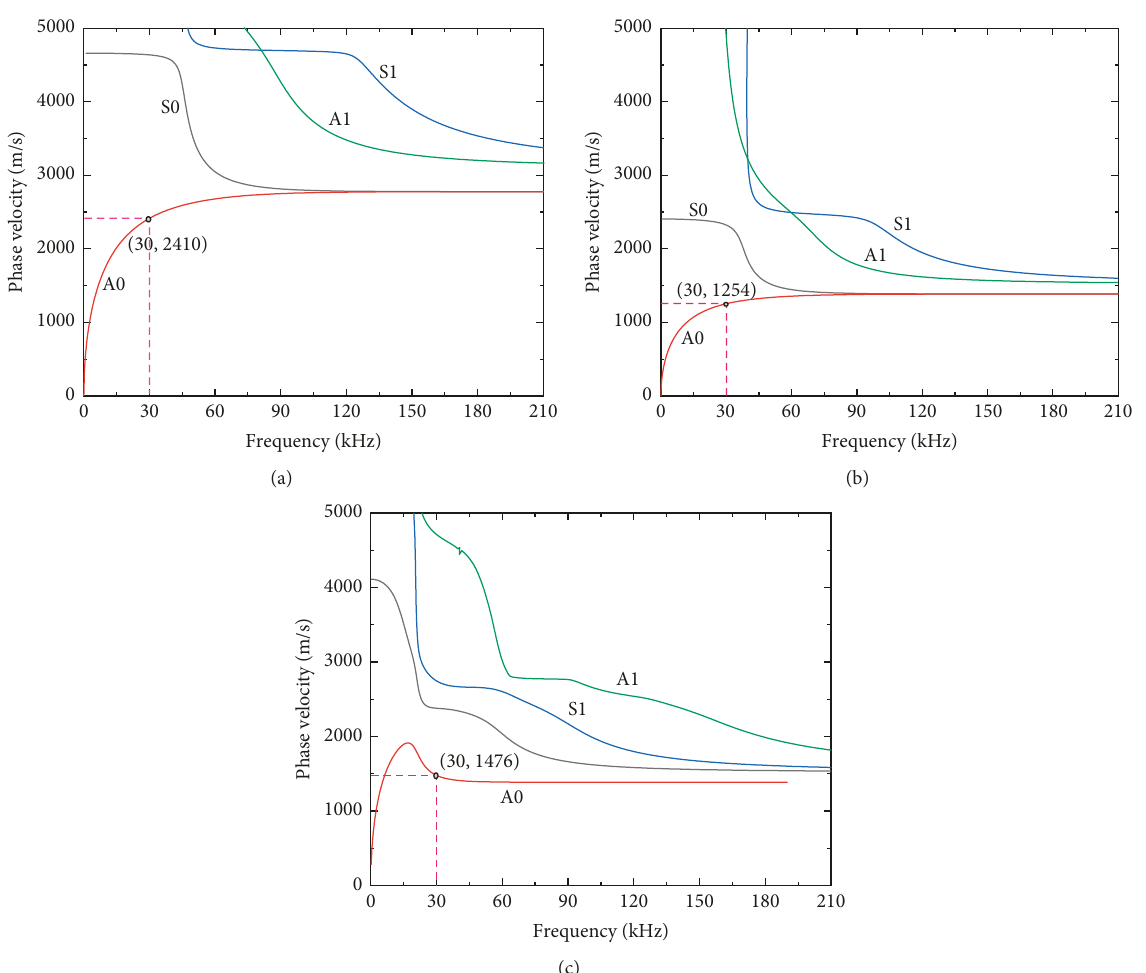
Figure 4: Phase velocity dispersion curves: (a) the first layer; (b) the second layer; (c) two